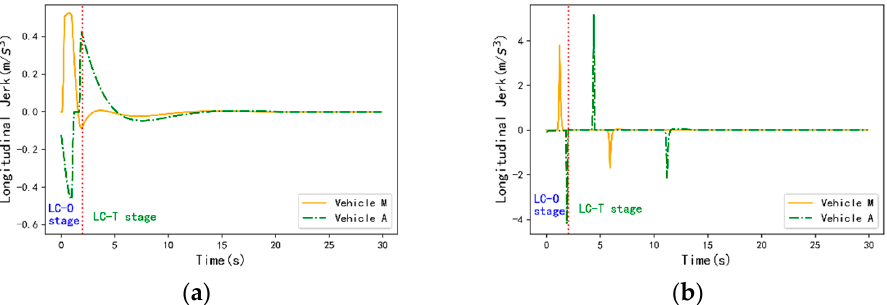
Figure 15. The longitudinal jerks of vehicles M and A of the two control strategies in scenario 2. ( a ) The proposed CLC control strategy, ( b ) CACC_Sine control strategy.